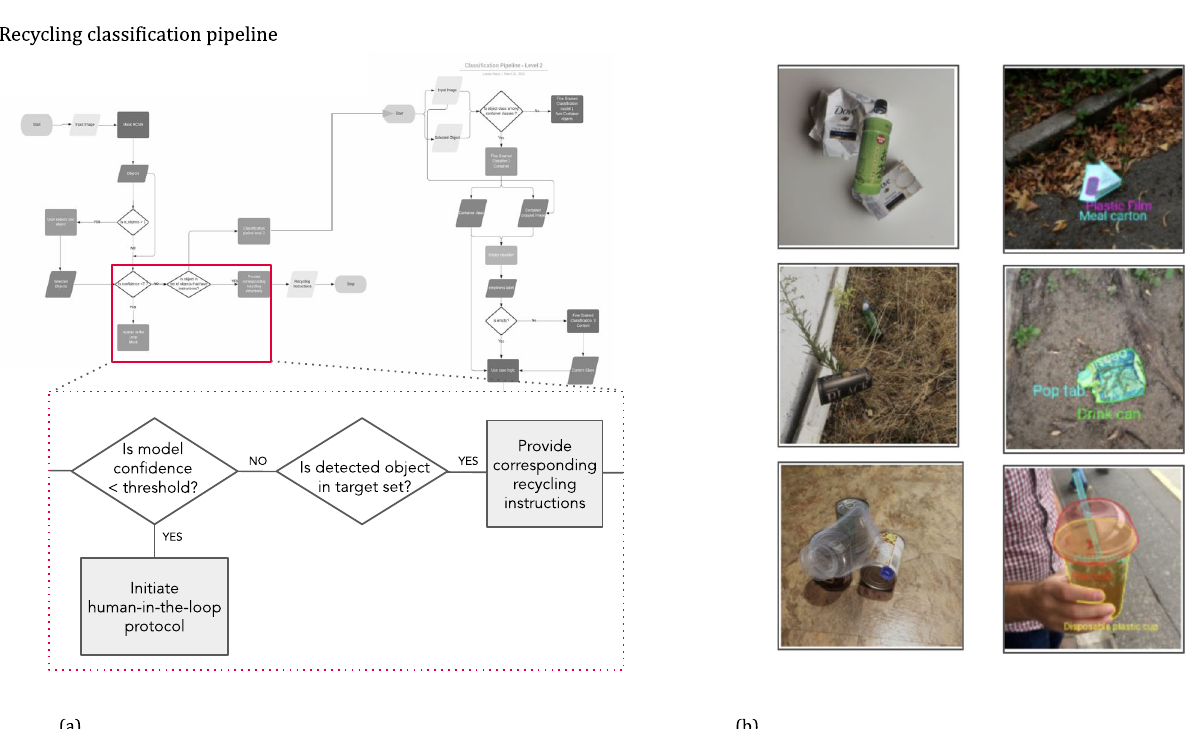
Fig. 5 | Computer vision pipeline for an automated recycling application (a), which contains multiple ML models, user input, and image data from various sources. Complicatedlogic suchas this canmaskML model performance lags and failures, and also emphasized the need for R& D-to-product handoff described in